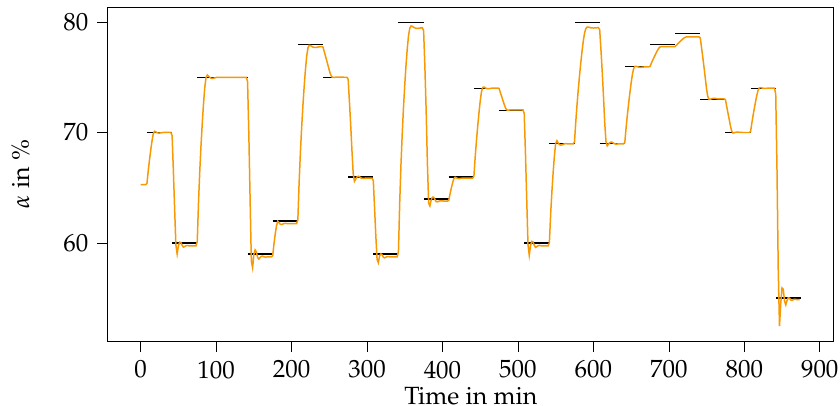
Figure 9. Corrected ANN-Control model tested on the original